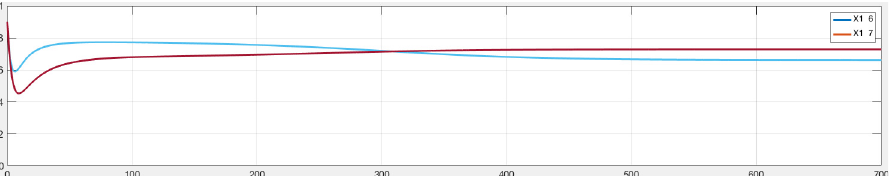
Fig. 7. Simulation results for suppression and Hebbian learning for ! 1 (connection X 1 – X 6 ) and ! 2 (connection X 1 – X 6 ) (Scenario